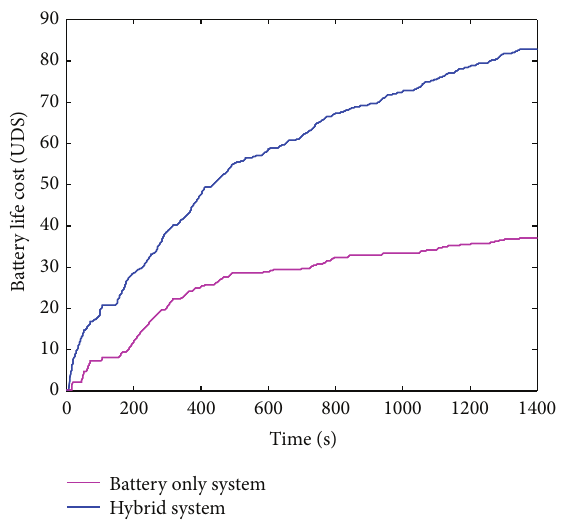
Figure 38: Comparison of the battery life cost based on UDDS driving cycle.